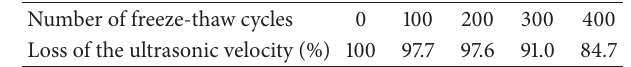
Table 4: Decreasing percentage of the ultrasonic velocity after freeze-thaw